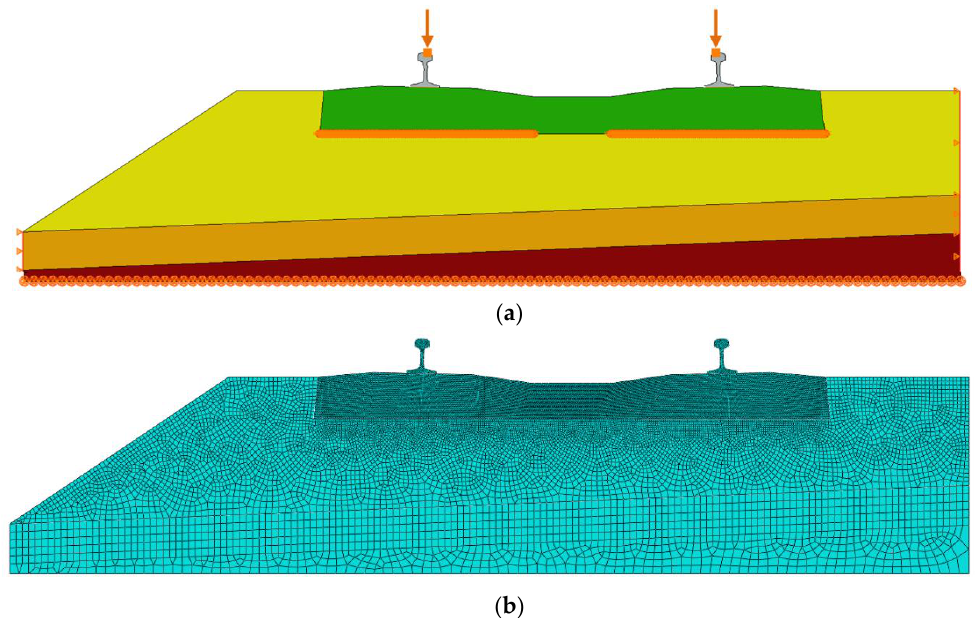
Figure 2. Finite element (FE) model of the ballasted track structure: ( a ) Geometry, boundary conditions, loads, concentrated masses and spring-dashpot systems (layers: grey — rails, green — sleeper, yellow — ballast, orange — protection layer, brown — soil subgrade); ( b ) FE mesh.